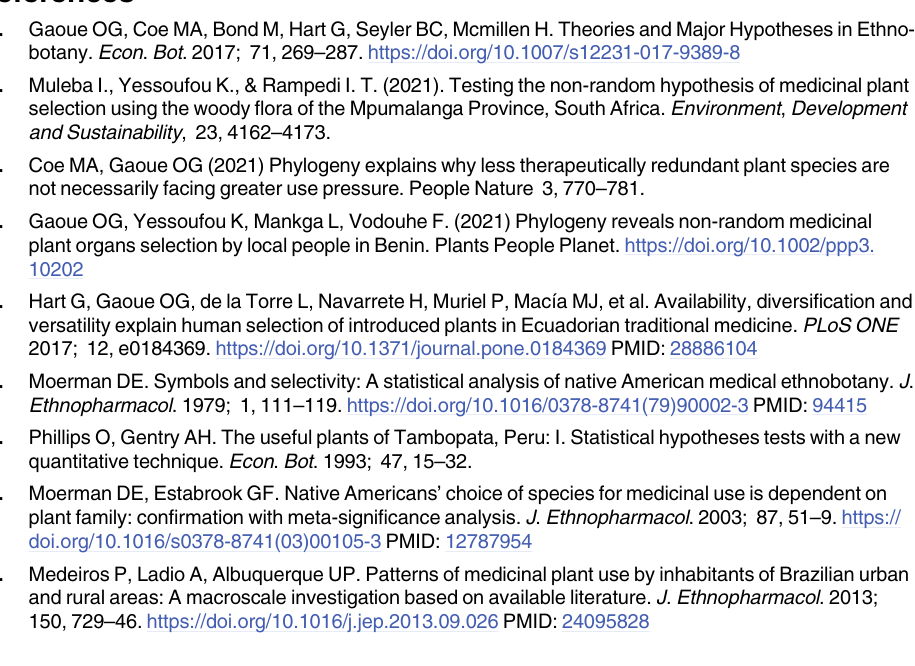
S4 Table. Residual values for each plant